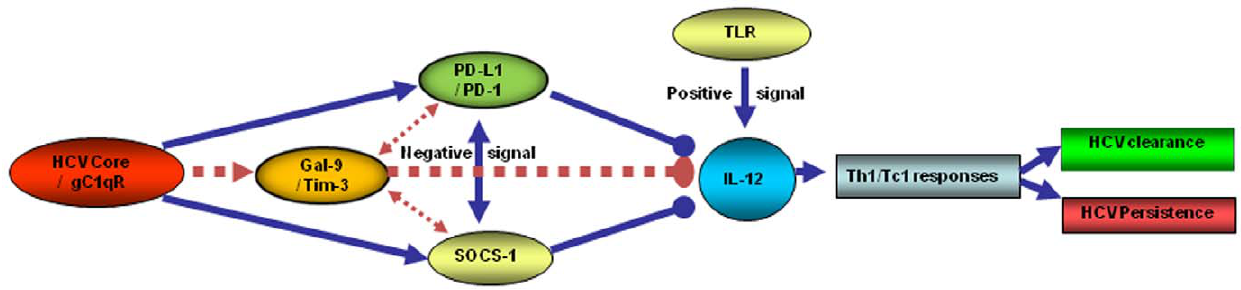
Figure 9. A Model for the HCV core/gC1qR-induced negative signaling (Tim-3/PD-1/SOCS-1) molecules in regulation of IL-12 and Th1/Tc1 responses during HCV infection. We have previously shown that HCV core/gC1qR interaction up-regulates PD-1 and SOCS-1 negative signaling molecules, leading to suppression of TLR-mediated IL-12 production. In this study, we further demonstrated that the Tim-3 inhibitory pathway is involved in the HCV core/gC1qR-induced inhibition of IL-12 expression by M/M F during HCV infection. Specifically, we found that Tim-3 can be up-regulated by HCV core/gC1qR interaction, which in turn, inhibits TLR-mediated IL-12 production. We also found that Tim-3 can crosstalk with other inhibitory molecules such as PD-1 and SOCS-1 to coordinately inhibit TLR-mediated IL-12 signaling pathways during HCV infection. We conclude that HCV-mediated innate immune dysregulation (impaired M/M F IL-12 production) may ultimately lead to adaptive Th1/Tc1 dysfunction, and thus, HCV